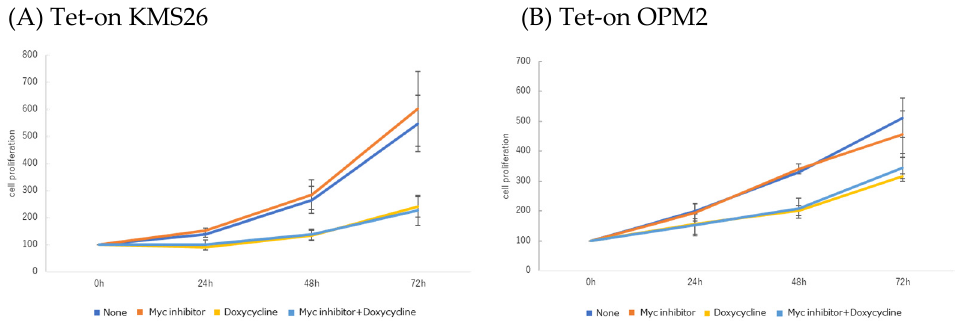
Tet-on OPM2, but the Myc inhibitor, either alone or in combination with p53 expression, by forced p53 expression but was not increased by the Myc inhibitor in both cell lines.